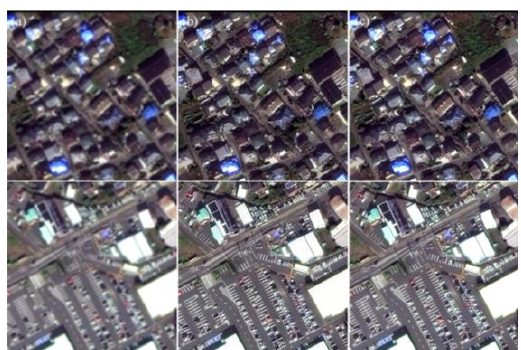
Figure 8 . Validation results of EXP1 (a) WV3 LR image (1.2 m)